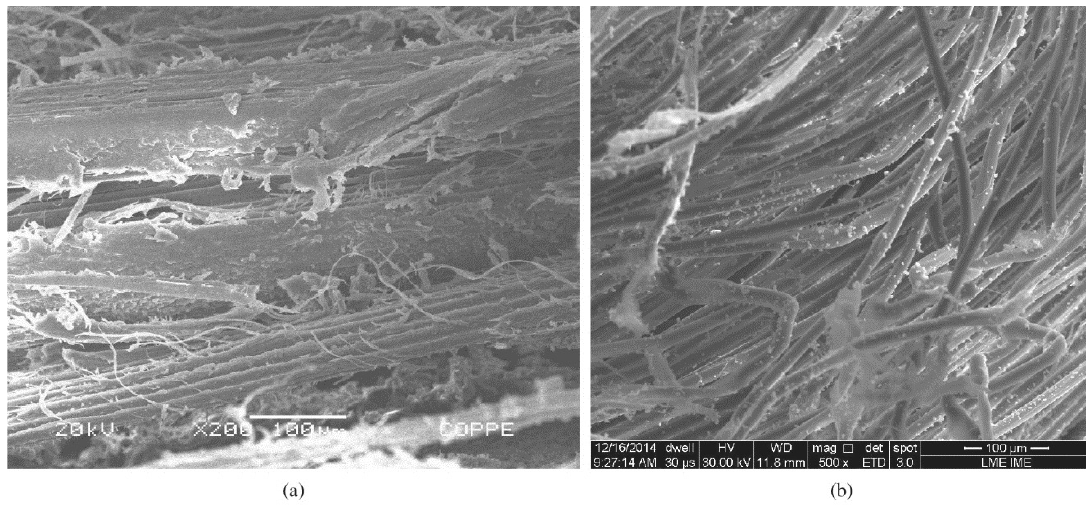
Figure 5. SEM of ballistic fracture of (a) giant bamboo fiber reinforced epoxy composite and (b) aramid fabric in a MAS. Source: authors. Table 2. Evaluation f weight and cost of the different multilayered armors. Armor